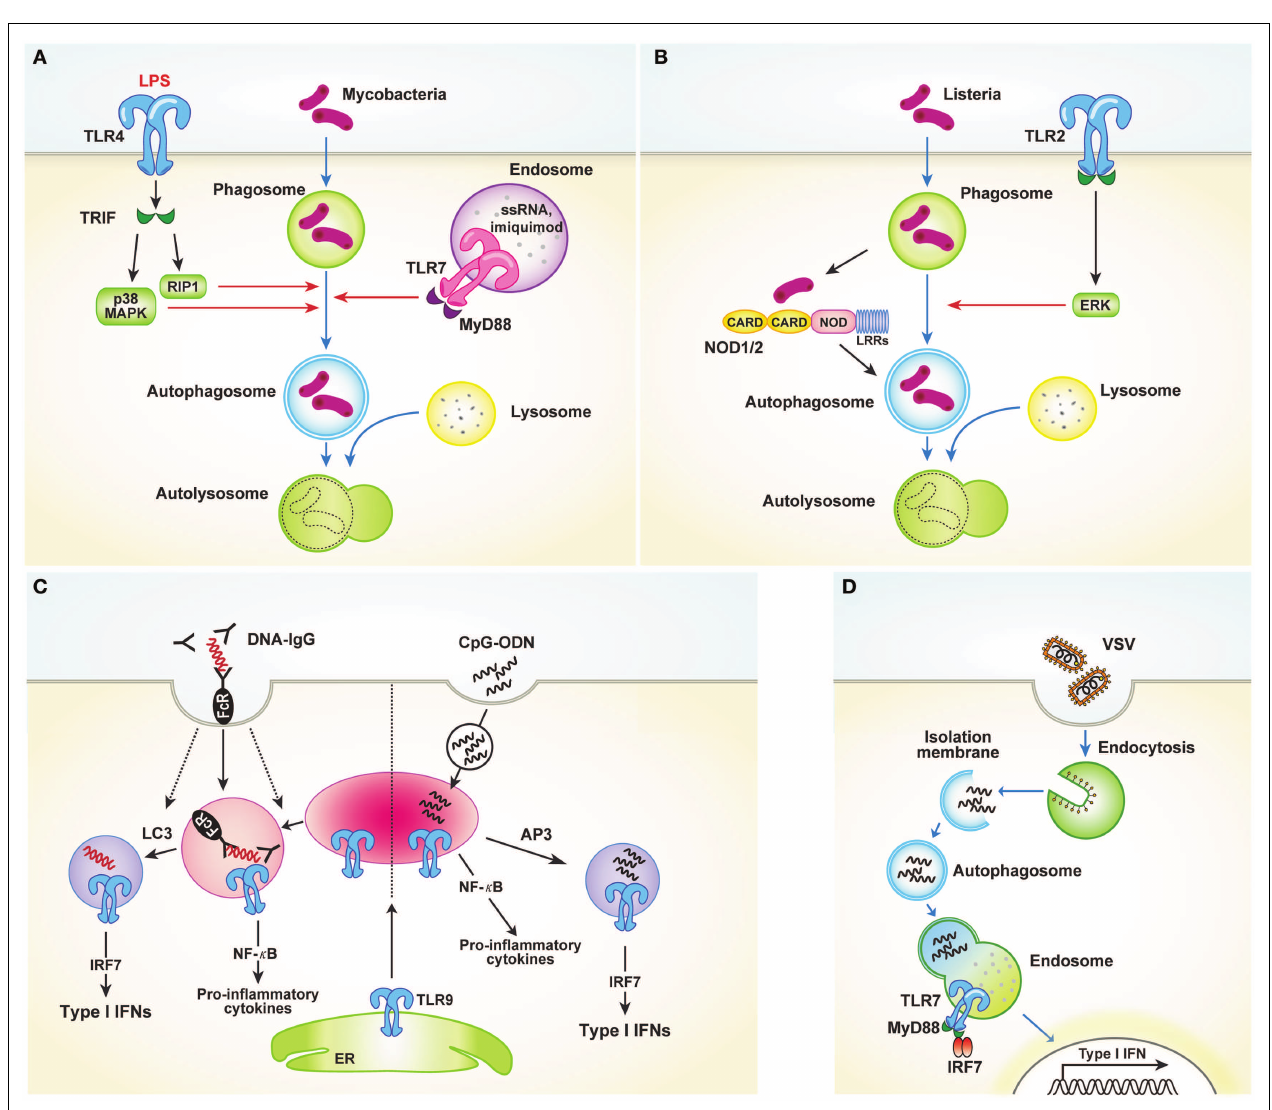
DNA-ICs. Large DNA-ICs engulfed by phagocytosis are internalized using Fc γ R, which recruits LC3 andTLR9–UNC93B to the phagosomes. Unlike NF- κ B-dependent inflammatory cytokine production, LC3 is required for the trafficking ofTLR9 into a specialized IRF7 signaling compartment for type I IFNs secretion. In response to the endocytosed CpG-ODN, however, AP3 is required for delivery to the IRF7 signaling compartment. (D) Autophagy facilitates the viral sensing by delivery of cytosolic viral PAMPs to lysosomes, enabling endosomalTLRs to sense of virus and